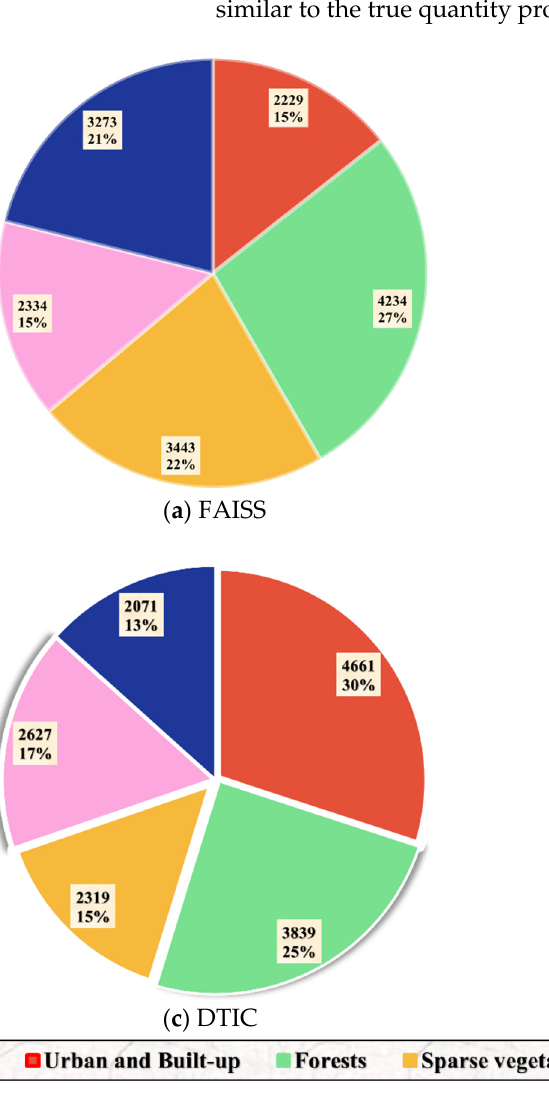
Figure 6. Quantity and percentage of each class on the Reunion Island Dataset using different methods implemented with random initial cluster centers. ( a ) FAISS; ( b ) K-means; ( c ) DTIC; ( d ) true proportion.